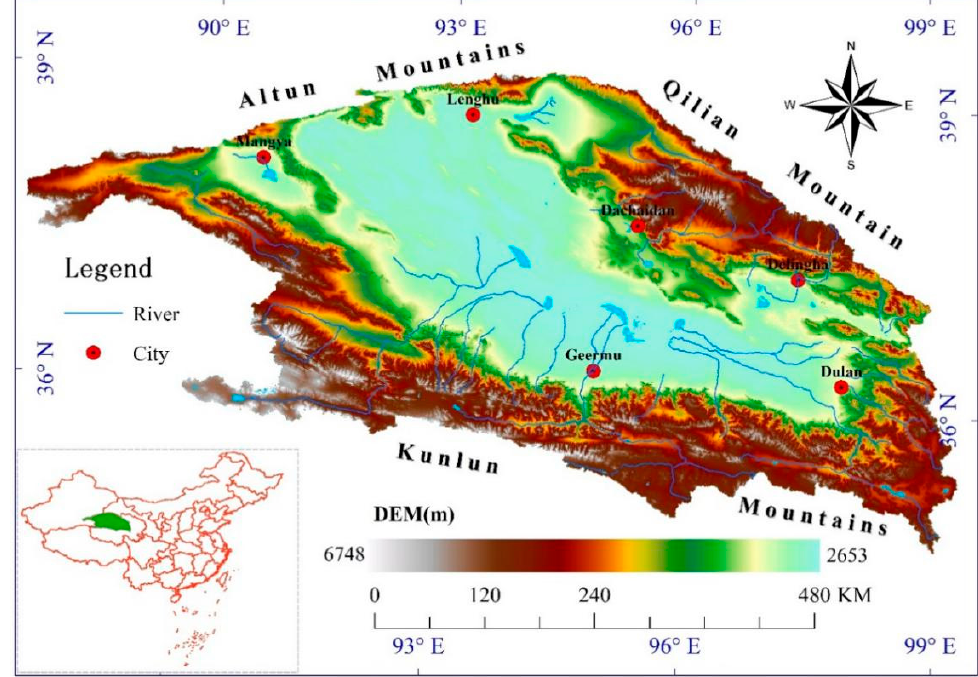
Figure 1. The study area of the Qaidam